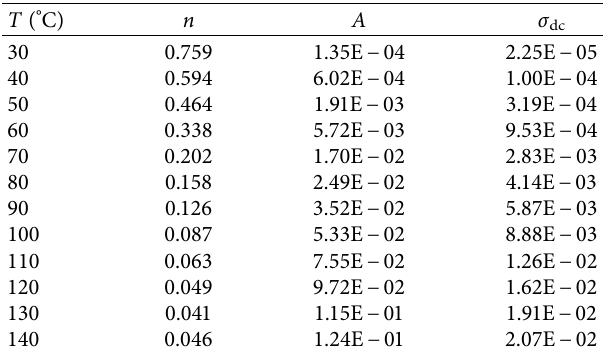
Table 6: Values of the exponent n , coefficient A and the dc conductivity for pure 2 wt.% FeCl 2 PVA/PVP electrolyte blend